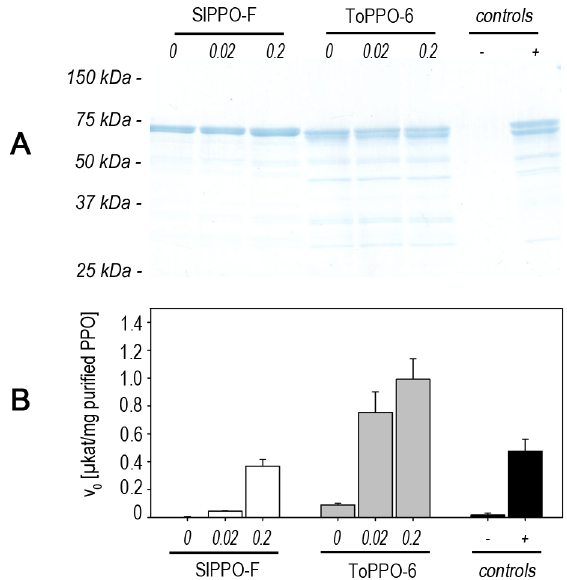
Figure 9. Transferability of the improved expression system to further eukaryotic PPOs. Further eukaryotic PPOs (s. Table 1) were cloned and heterologously expressed in E. coli Rosetta 2 (DE3) [pLysSRARE2]. Production cultures were grown with different concen- trations (0 mM, 0.02 mM, 0.2 mM) of supplemented CuCl 2 in AIM. A SDS-PAGE of purified proteins. Cultures were harvested after 48 h and recombinant PPOs were purified via affinity-chromatography using Strep-Tactin. Equal protein amounts were loaded on an acrylamide gel and analyzed via SDS-PAGE using Coomassie staining. B Specific PPO- activity after purification. Activity (v 0 ) was analyzed per mg purified protein for 4-methylcatechol as substrate. Purified ToPPO-2 produced with 0.2 mM CuCl 2 supplementation served as positive control ( + ) and buffer as negative control (-).